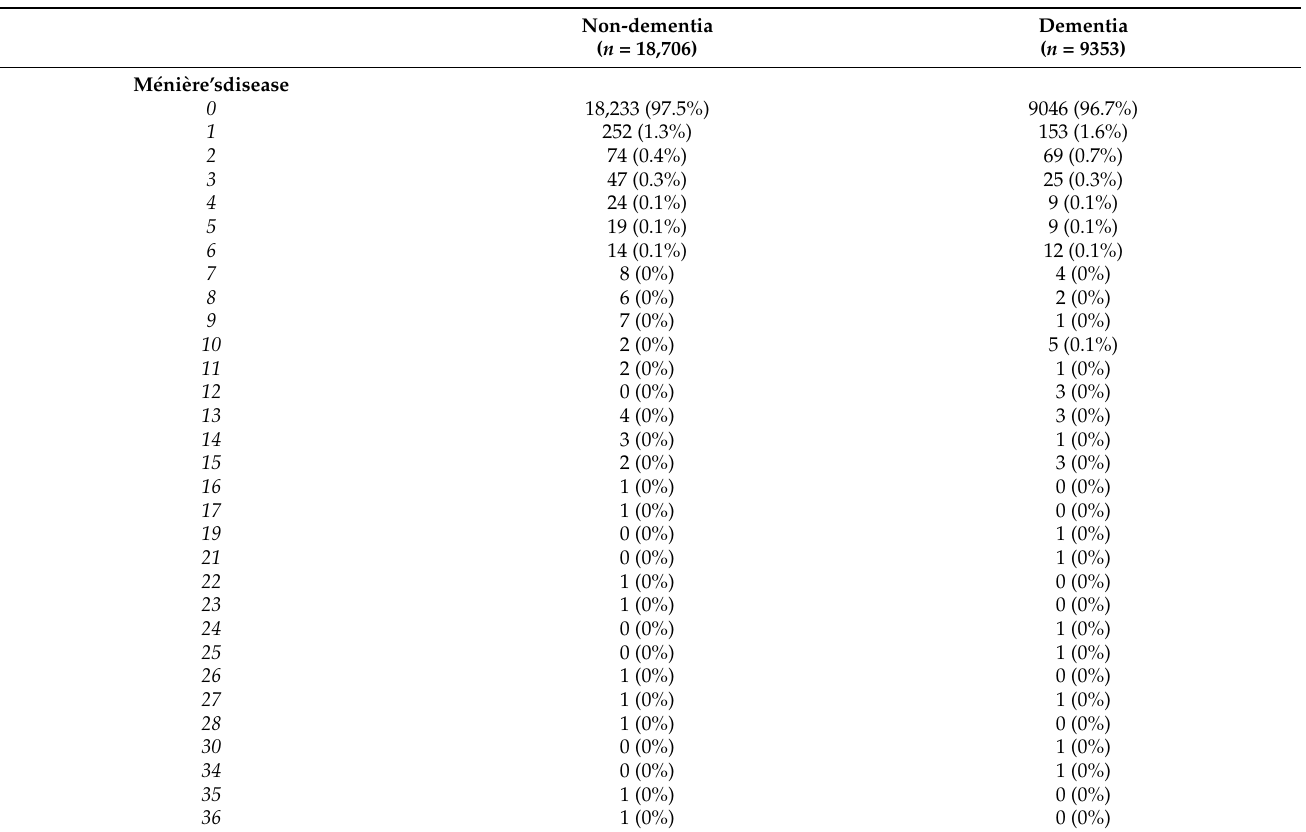
Table 7. Frequency table for M é ni è re’s disease episode between patients with dementia and